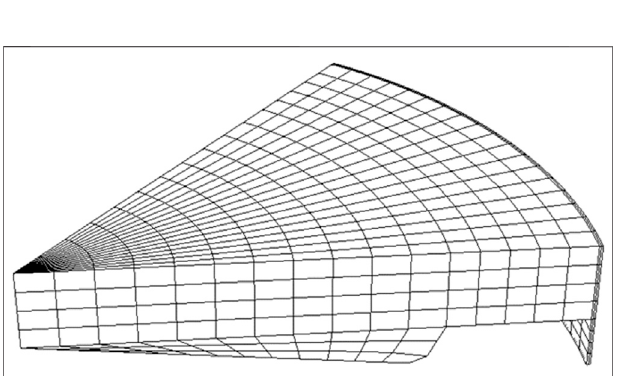
FIGURE1 | GT-POWER model schematic for GM 1.9L light-duty RCCI engine. The arrows show the direction of airand exhaust gas fl ows through the respective manifolds.